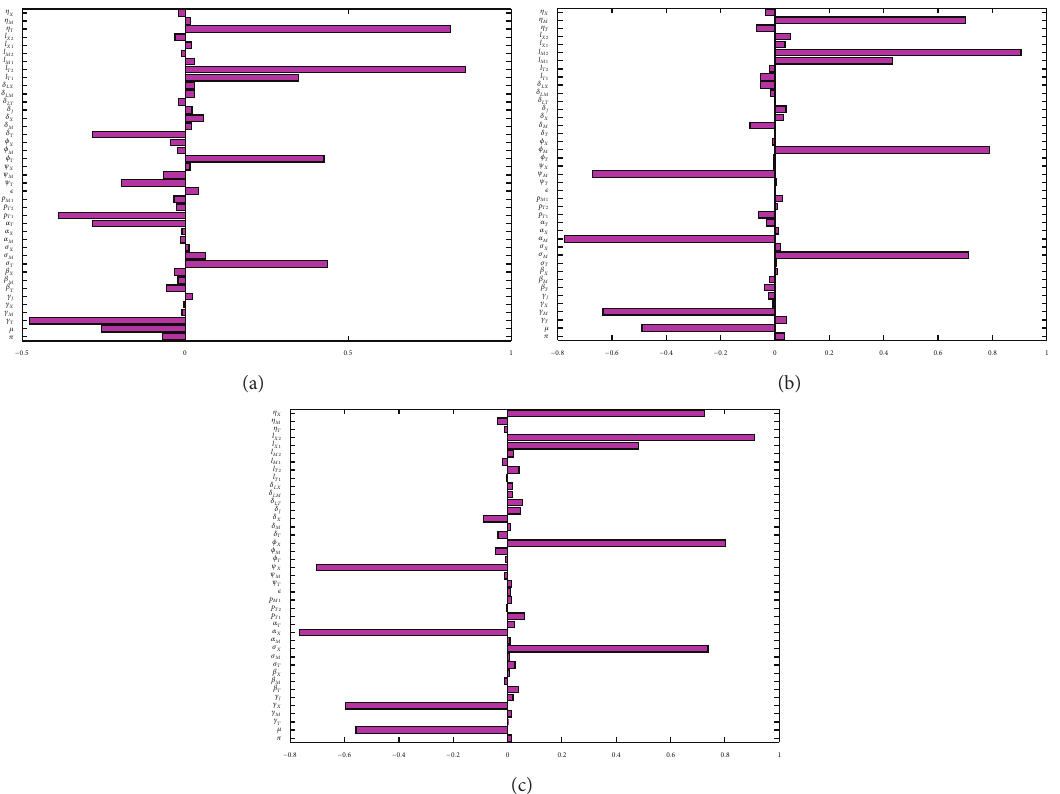
Figure 2: PRCC values for model (2), using as the response function (a) the basic reproduction number ( R 𝑇 ), (b) the basic reproduction number ( R 𝑀 ), and (c) the basic reproduction number ( R 𝑋 ). Parameter values (baseline) and ranges used are as given in Table 2.